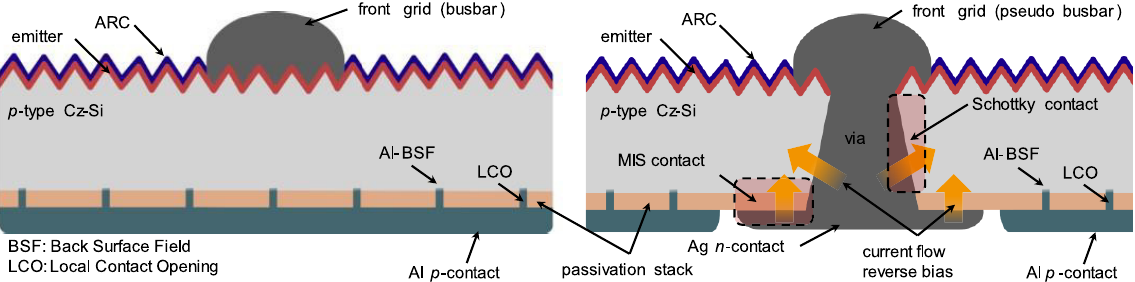
Fig. 1. Cross sections of PERC (left) and HIP-MWT+ (right) cells showing the differences of the two cell concepts. The HIP-MWT+ cell features the additional through-metallization (via) which creates two additional electrical contacts in the cell, namely the MIS contact and the Schottky contact. The vias allow locating the n -contact and p -contact next to each other on the rear side of the cell (right). The yellow arrows show the current fl ow under reverse bias for the AlO X based passivation. This way the integrated bypass diode